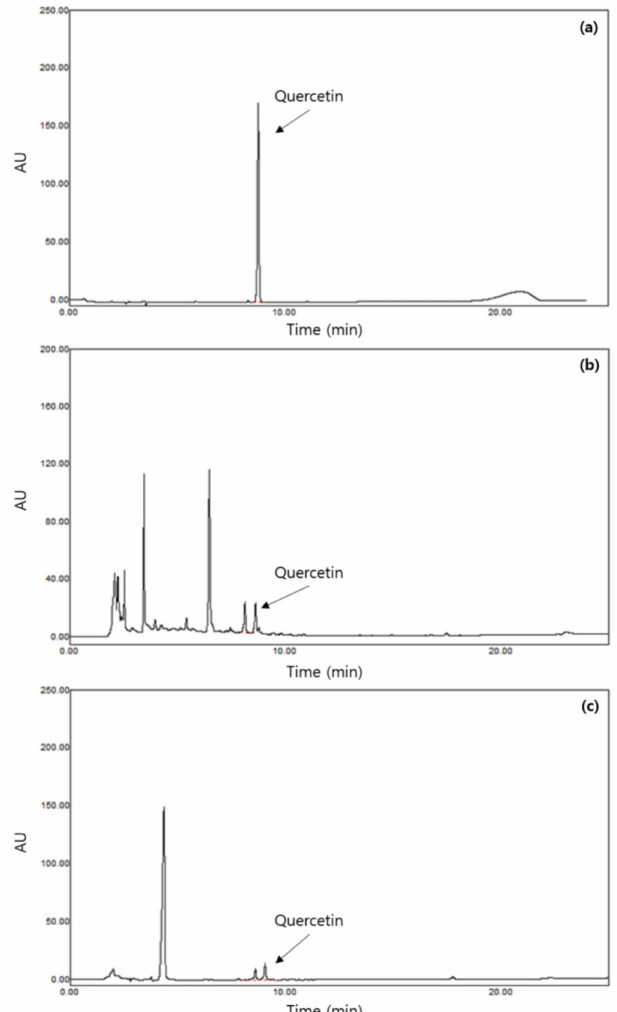
Figure 1. Comparison of HPLC chromatogram of quercetin and two samples: ( a ) quercetin standard; ( b ) AW, hot water extraction of outer layers of leaf skin of Aloe vera at 100 ◦ C for 24 h; ( c ) AF, L. plantarum fermentation of outer layers of leaf skin of Aloe vera at 37 ◦ C for 3 days and further extracted by an ultrasonicator at 40 kHz for 1 h at room